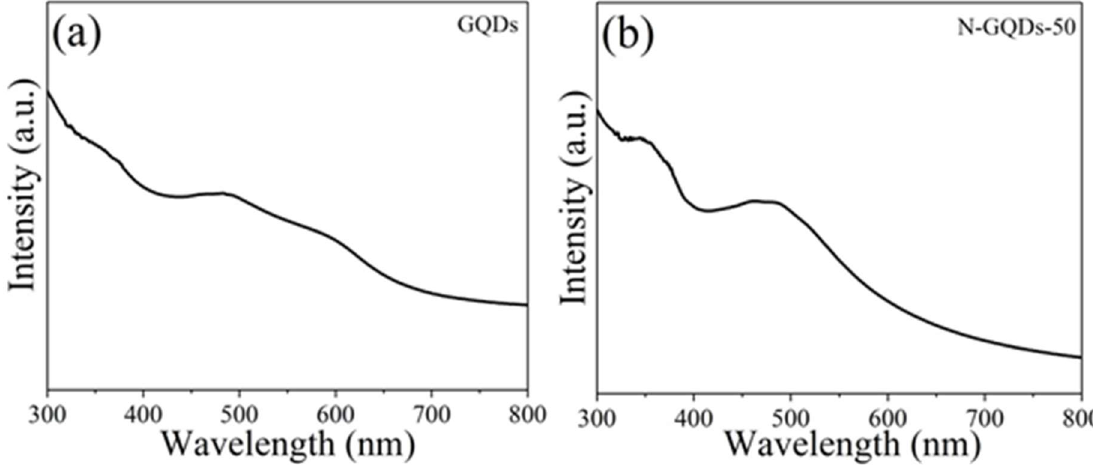
Figure 4. The UV-vis absorption spectra of the GQDs ( a ) and N-GQDs-50 ( b ).